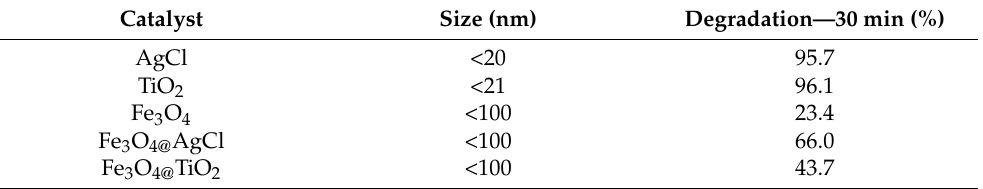
Table 2. Degradation achieved by different nanocatalysts after 30 min under UV–Vis light (Initial concentration of ATL, 10 ppm; nanomaterials, 0.75